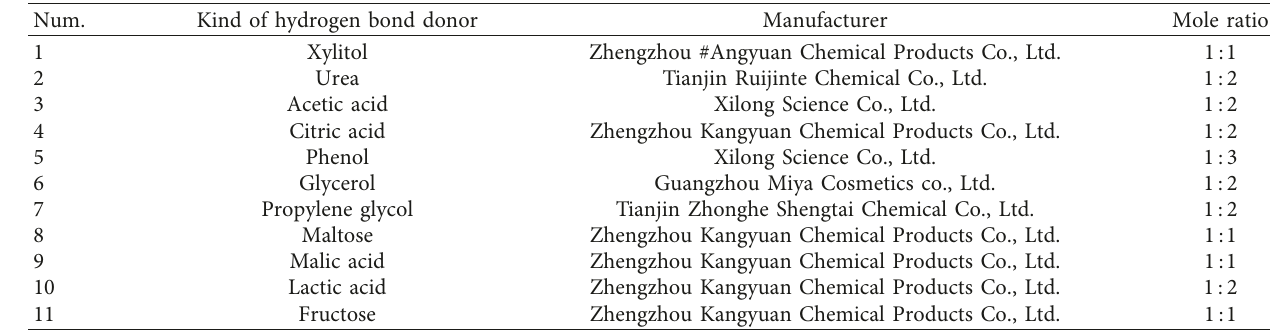
Table 1: Sources of hydrogen bond donor.